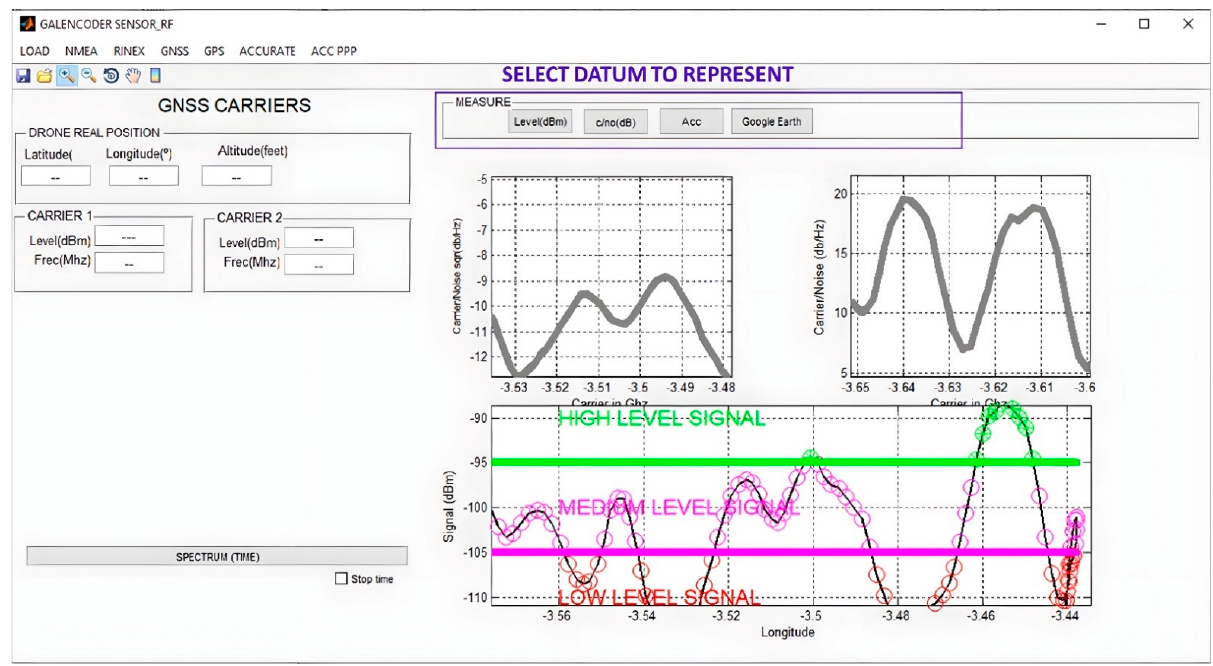
Figure 12. Information displayed by the GUI.